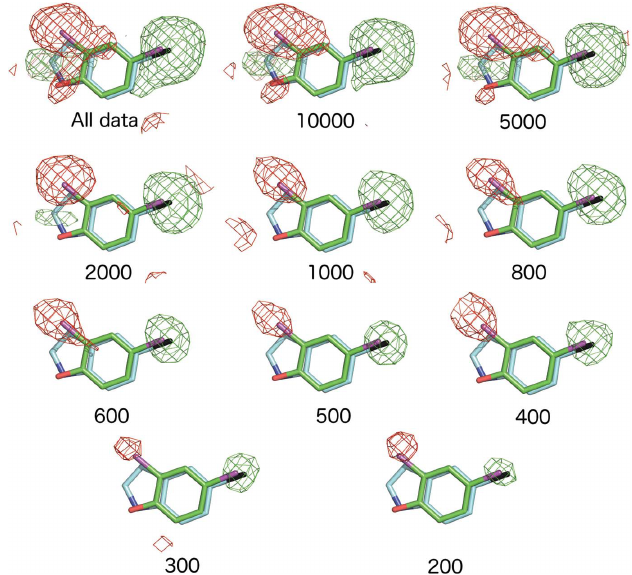
Figure 5 F o (cid:3) F o isomorphous difference maps comparing the 5BR and DCP ligand complexes of DHP. Maps are F o (5BR) (cid:3) F o (DCP) contoured at 3 (cid:5) . With all data included, the map shows a clear positive peak near to the position of the Br atom of 5BR (black) and one of the Cl atoms of DCP (magenta), consistent with the greater number of electrons in bromine. A negative peak is present at the position of the second Cl atom of DCP, where the closest atom of 5BR is a carbon. An additional but weaker positive peak is present close to the C5 atoms of 5BR where no atom is present in